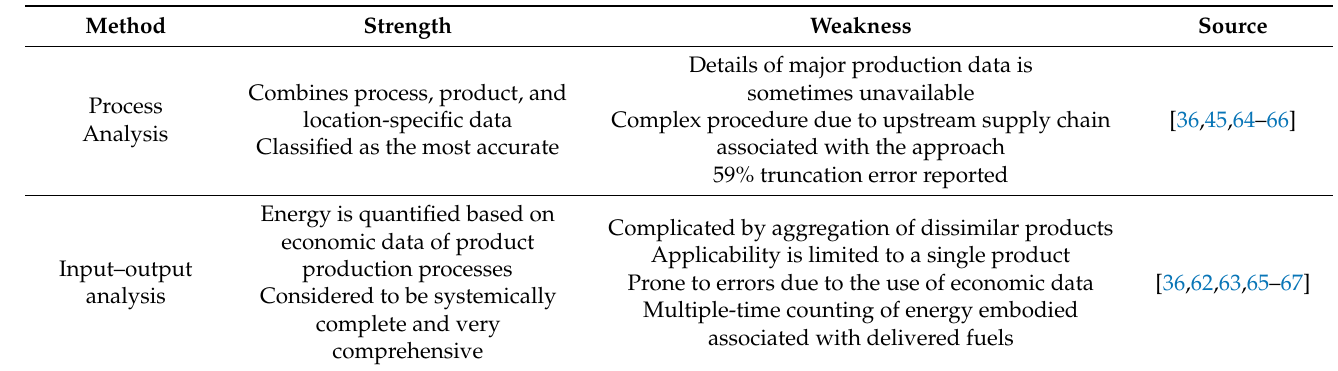
Table 1. Comparison between the process and input–output